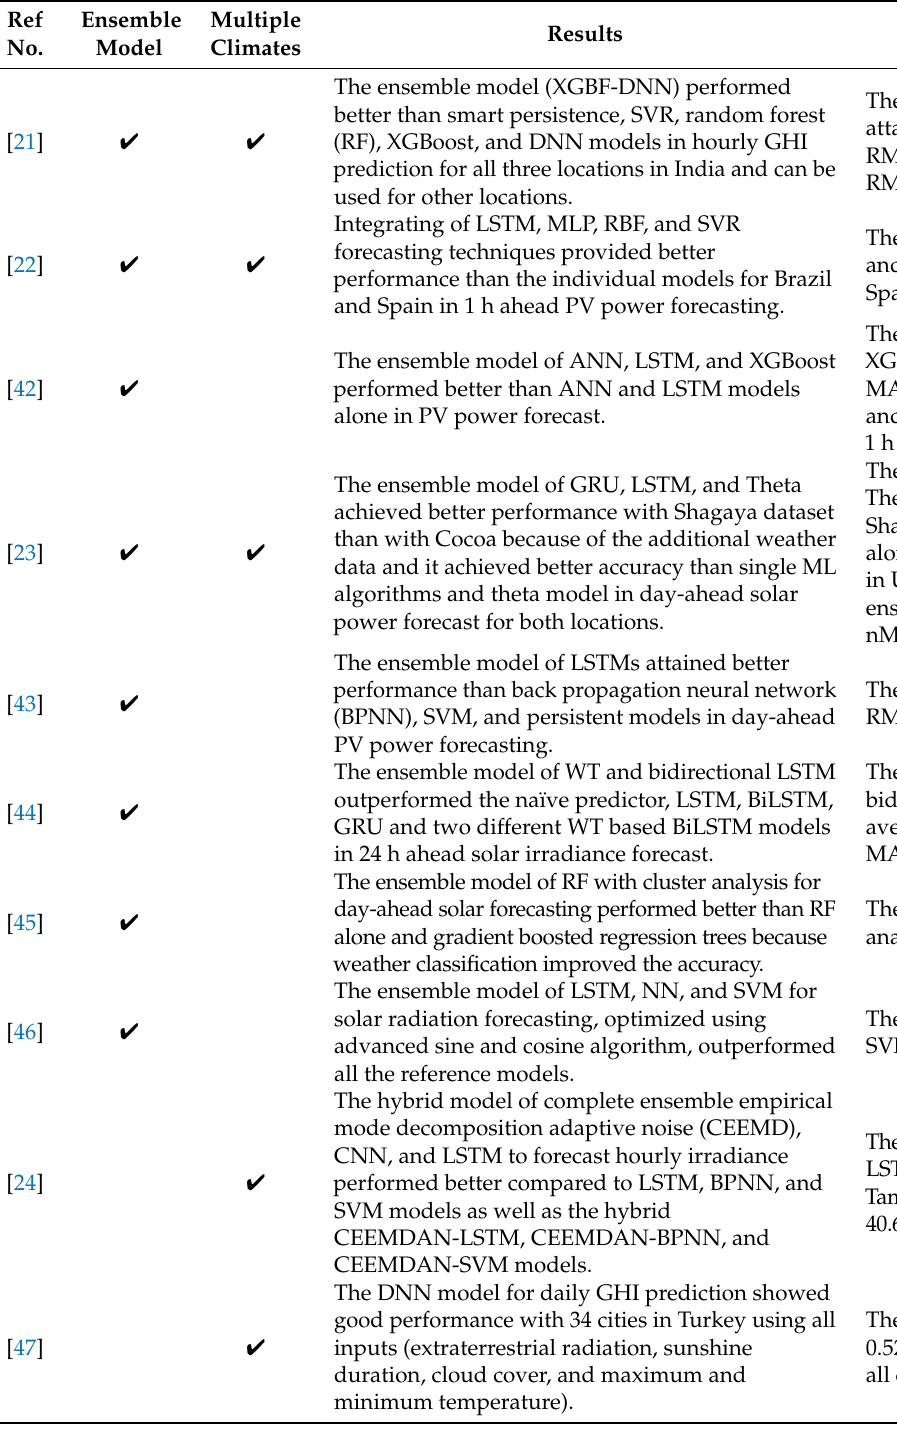
Table 1. Summary of the literature